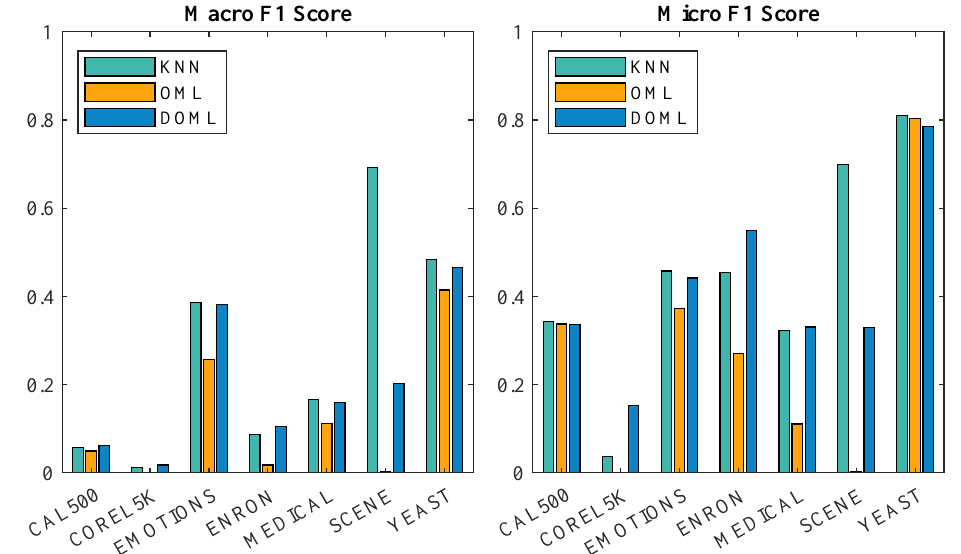
Figure 4. F1 score of different algorithms with full benchmark